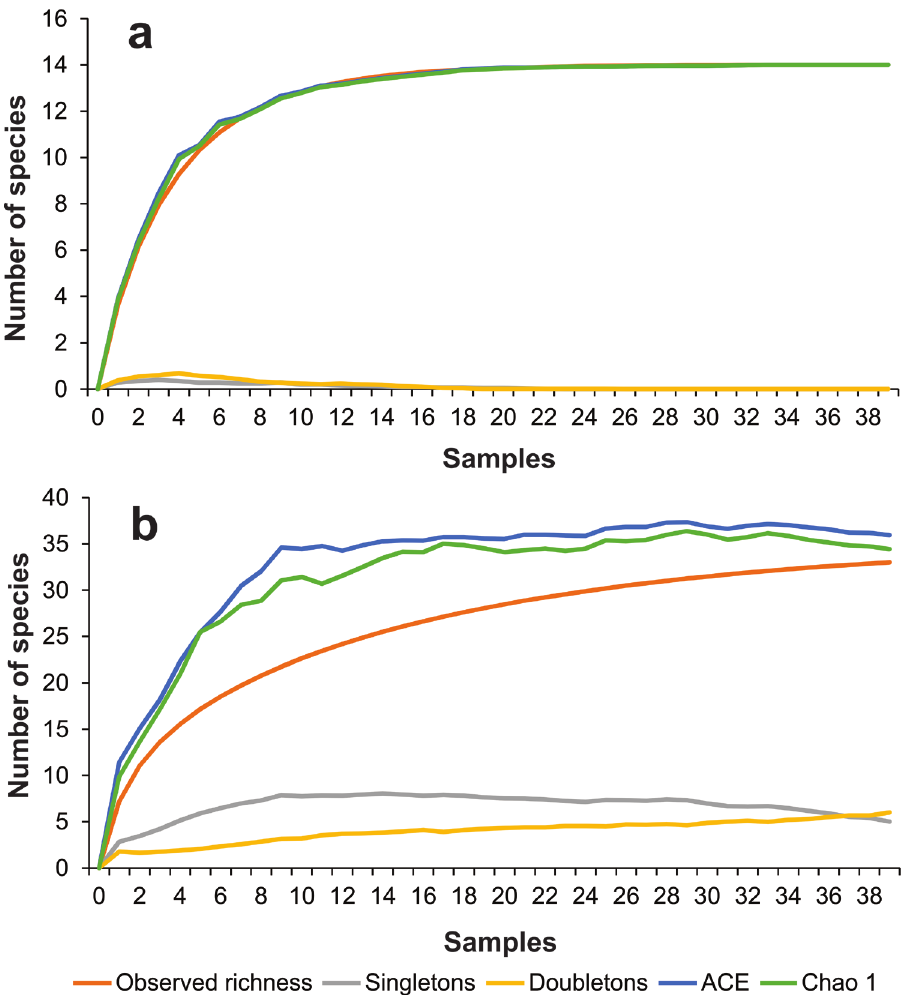
Figure 4. Species-accumulation curve of amphibians ( a ) and reptiles ( b ) outside REBSSJ. Observed richness, species represented by a single individual (singletons), species with two individuals (doubletons), and estimated species (ACE and Chao